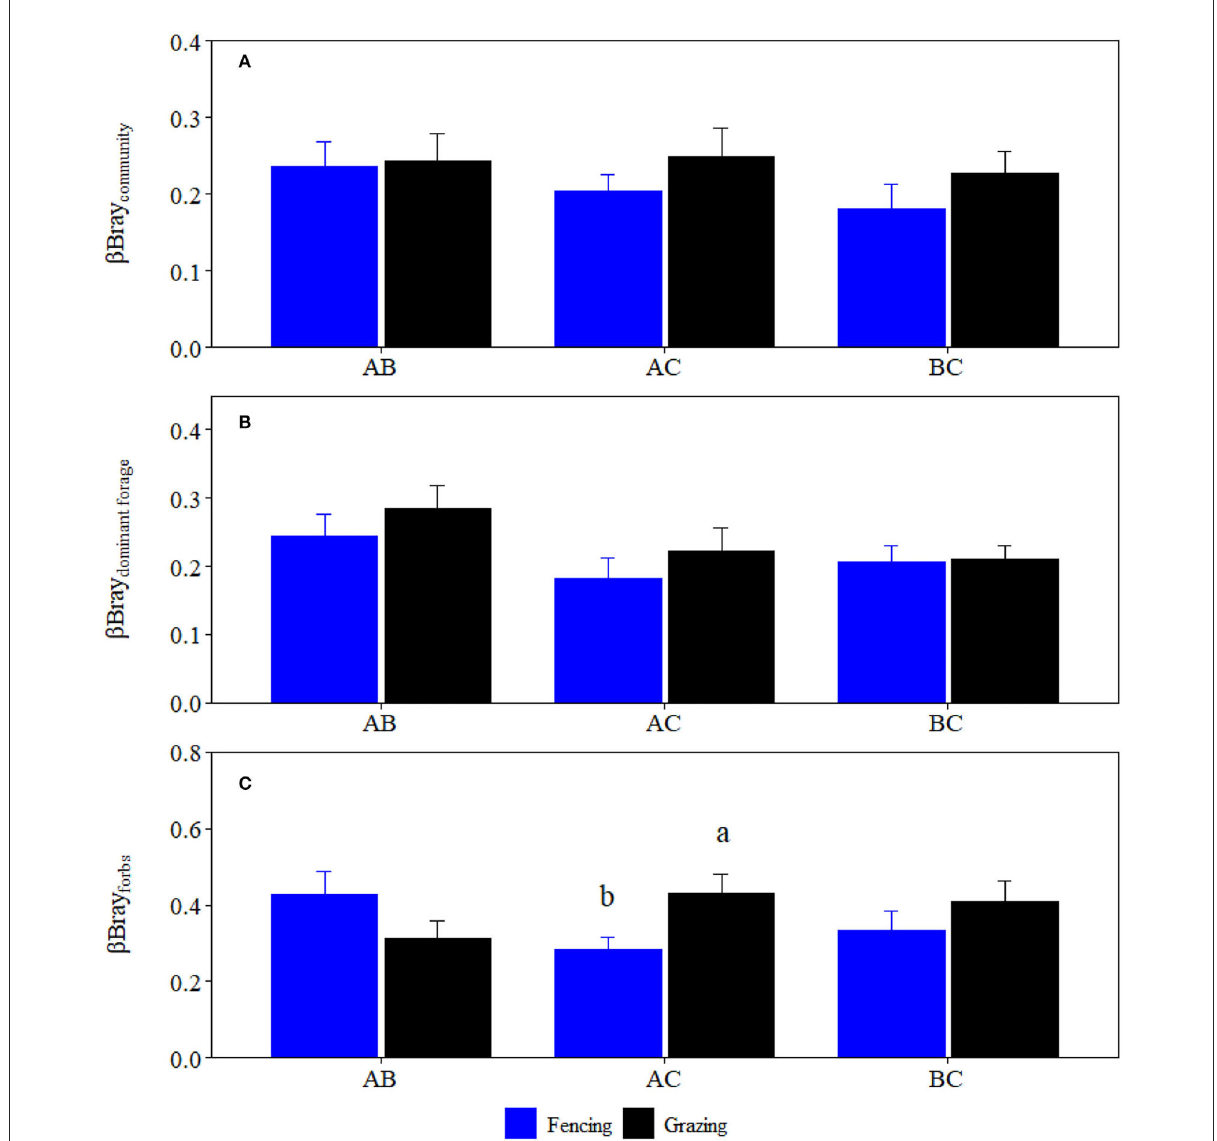
FIGURE5 The β Bray values (mean ± SE) between any two of the three sites for (A) plant community, (B) high-quality forage, and (C) forbs under fencing and grazing conditions, respectively. Different letters indicated significant difference at p < 0.05 level. AB, AC, and BC indicate the β Bray between sites A and B, between sites A and C, and between sites B and C,